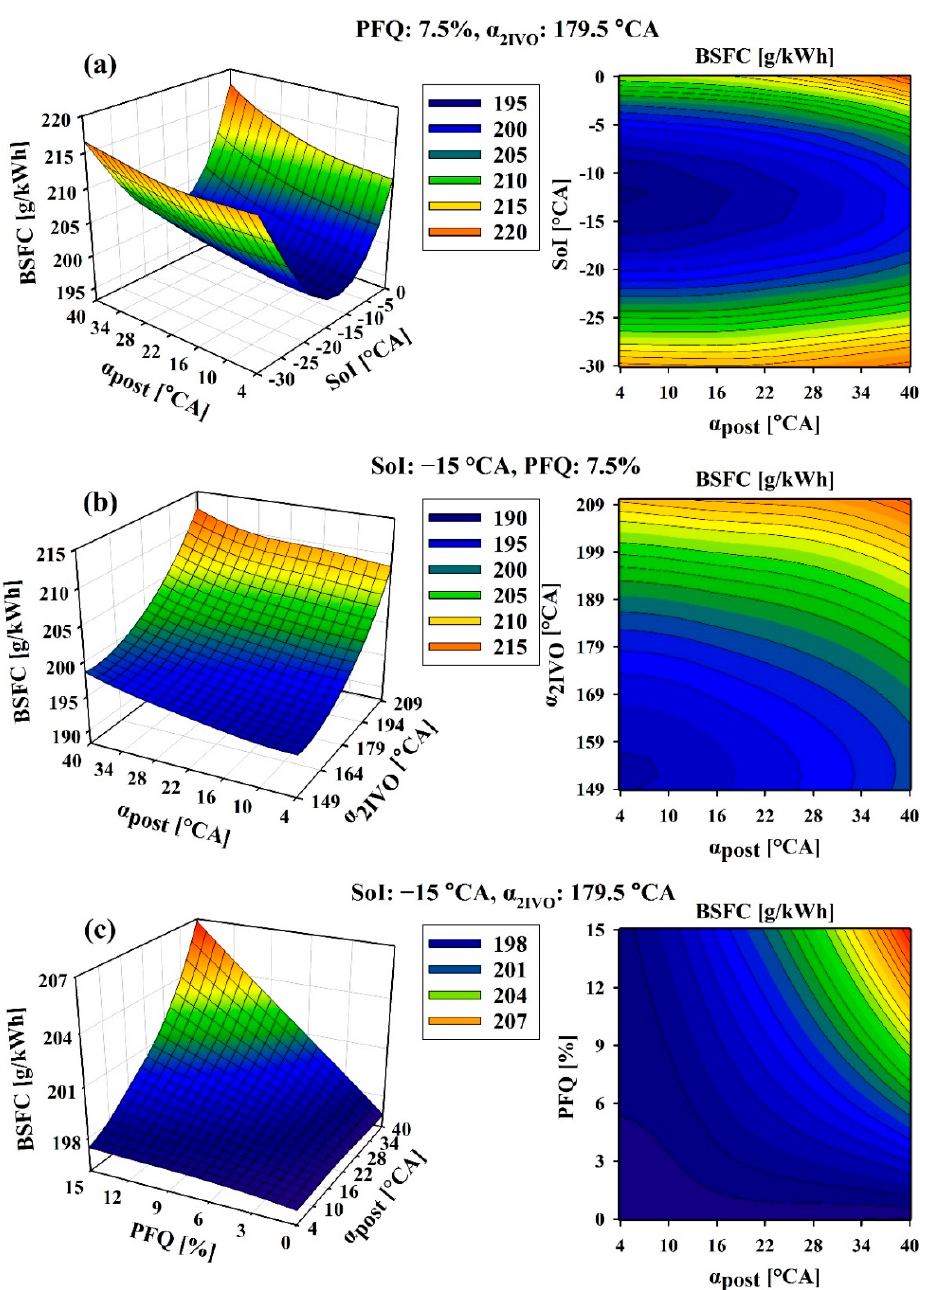
Figure 15. BSFC response surfaces for ( a ) α post —SoI, ( b ) α post — α 2IVO and ( c ) PFQ— α post .